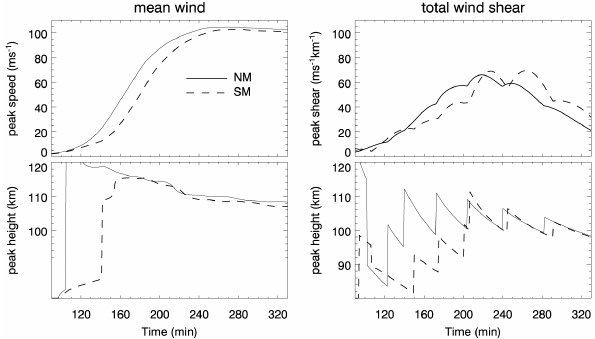
Figure 8. Temporal evolution of the peak speed (upper two panels) and peak height (lower two panels) of mean wind (left two panels) and total wind shear (right two panels) for the cases NM (the solid lines) and SM (the dash